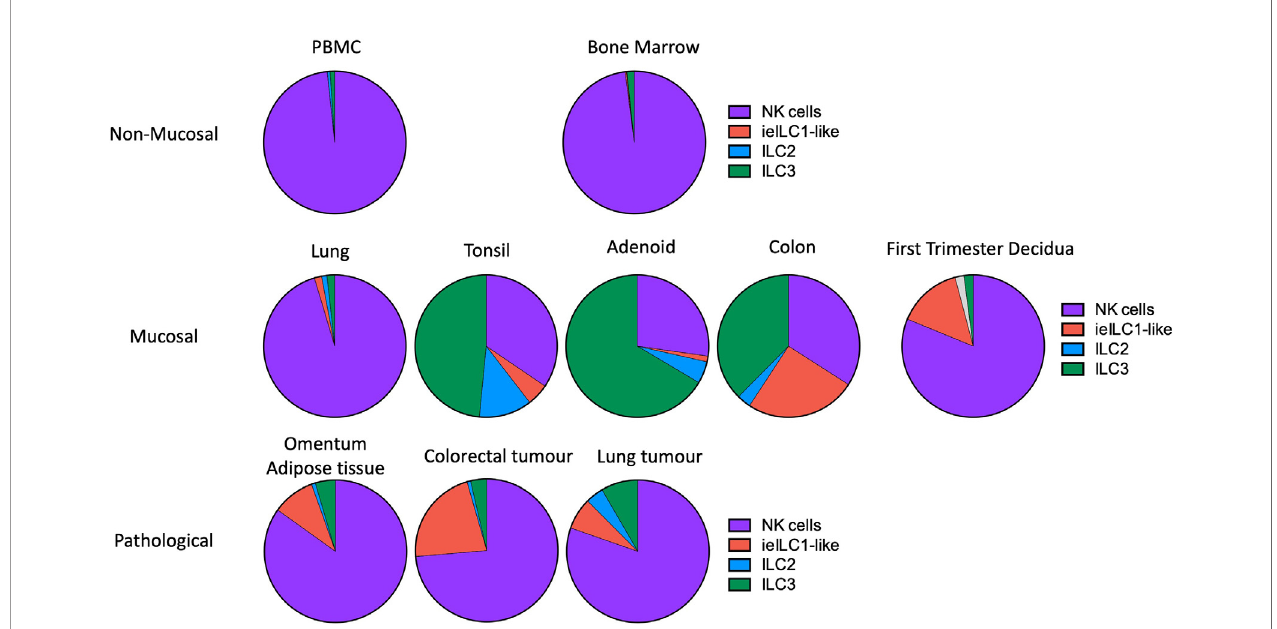
FIGURE 5 | Frequencies of NK and ILC populations in decidua compared with other human tissues. Pie charts showing the frequencies of NK and ILC subsets in decidua (N = 7) compared with normal and pathological human tissues determined by mass cytometry. All charts, with the exception of fi rst trimester decidua come from Simoni et al. (n = 4-9 separate donors for each tissue type) (33). For fi rst trimester decidua, Live CD45+CD3-CD19-CD14- HLA-DR- cells were gated on as the parent population [data from Huhn et al. (39)]. Speci fi ed subsets were then identi fi ed on a tSNE landscape based on phenotypic pro fi les and their proportion within this population calculated. Unassigned cells (grey in decidua) could not be con fi dently labelled as a particular subset based on the markers included in the CyTOF panel. For all other tissues, samples were fi rst depleted of T and B cells and then gated on Live CD45+ Fc ϵ R1 a – CD14 – CD19 – CD123 – CD34-CD5- cells. Gating strategies to identify each subset were then as follows: NK cells (purple) = CD94+/- CD127+/-CD56+CD103-; ieILC1-like (red) = CD94+/-CD127+/-CD56+CD103+; ILC2 (blue) = CD94-CD127+CRTH2+; ILC3 =CD94-CD127+CRTH2-. [Figure adapted from Simoni et al. and Huhn et al. (33, 39)].